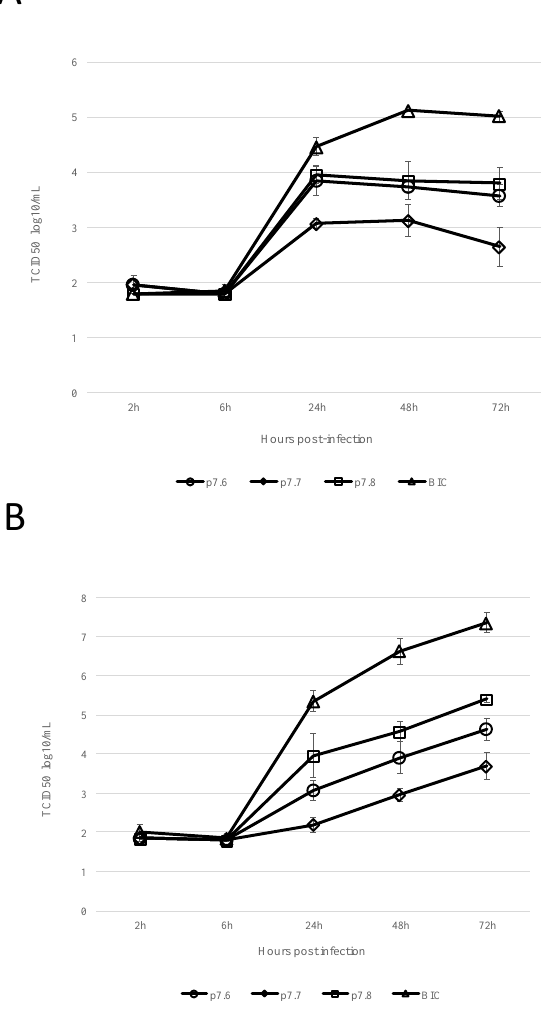
Figure 4. In vitro growth kinetics of CSFV mutants 7.6, 7.7 and 7.8 and parental CSFV BICv. ( A ) SK6 or ( B ) swine macrophage cell cultures were infected (MOI0.01). Virus yields, were titrated in SK6 cell cultures as described in Material and Methods. Data represent means and standard deviations from two independent experiments. Sensitivity of virus detection: ≥ log10 1.8 HAD50/mL.